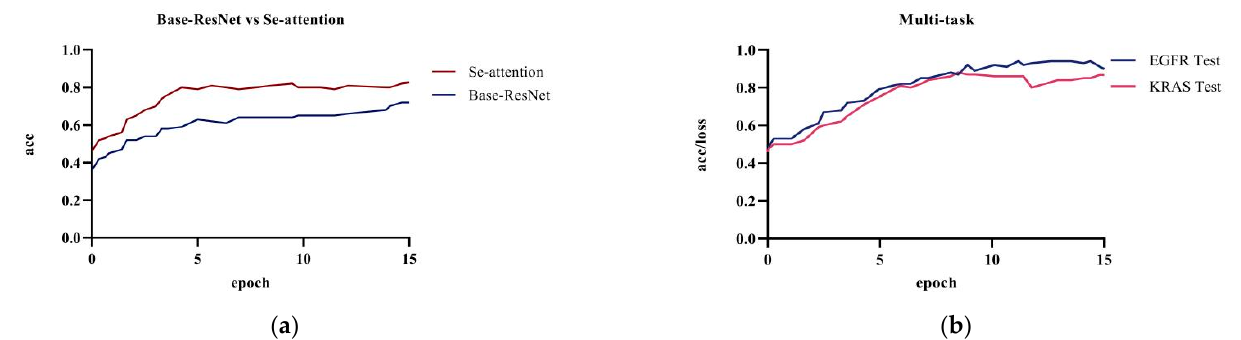
Figure 6. Experiment a, b, and d: ( a ) base Resnet and ResNet network with only the attention mechanism added; ( b ) multi-task training in the ResNet network.